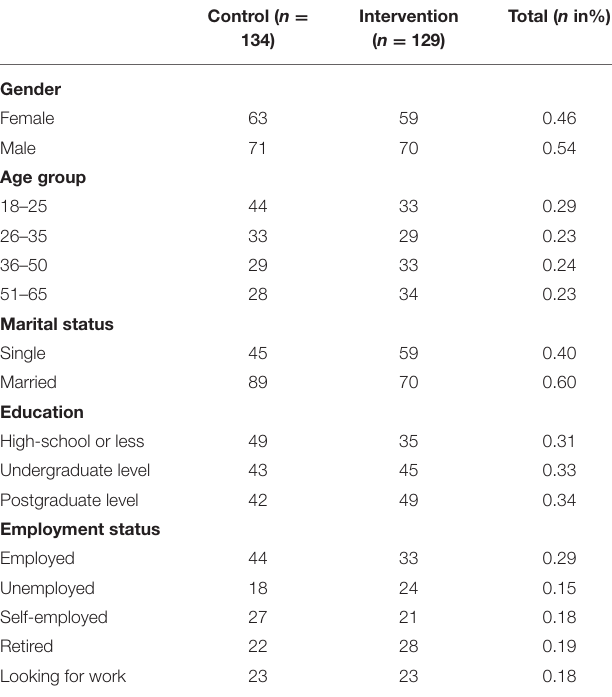
TABLE 4 | Patients’ demographic features ( N =